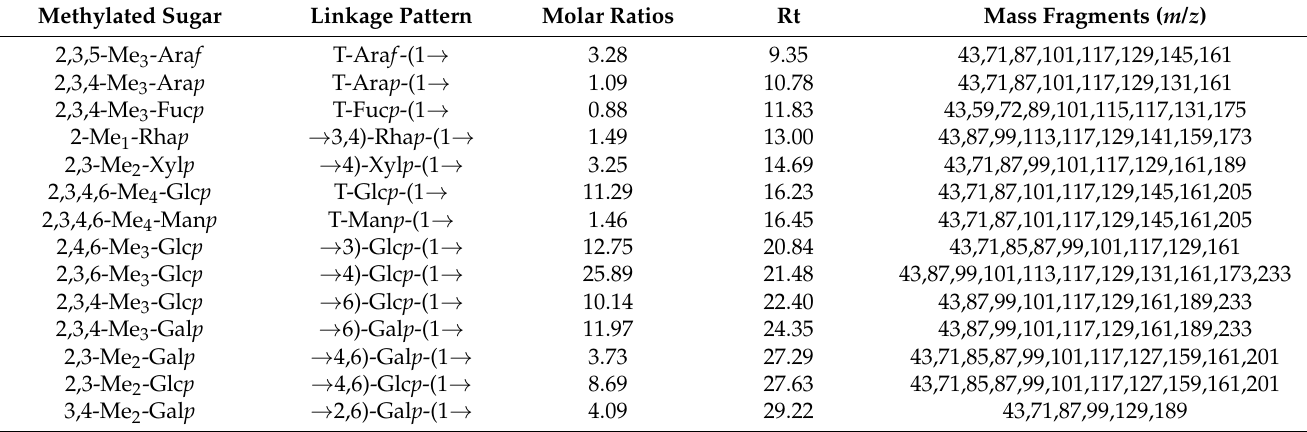
Table 2. Methylation analysis of GLP-1 by